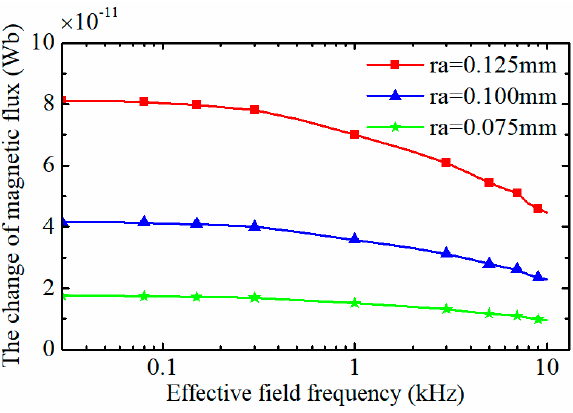
Figure 11. The change of the magnetic flux caused by wear debris under different effective field frequency.